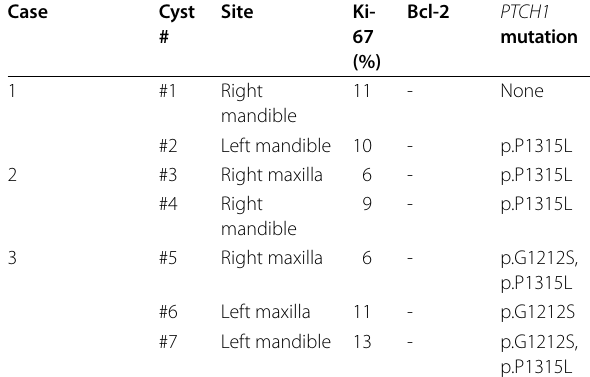
Table 2 Summary of immunohistochemical and molecular genetic